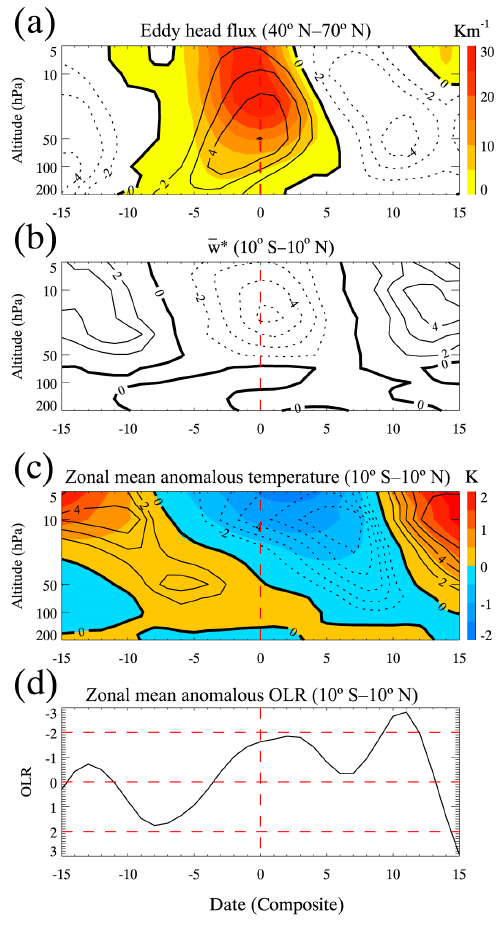
Figure 3. The time–altitude cross section of zonal mean (a) anoma- lous eddy heat flux averaged between 40 and 70 ◦ N shown in phys- ical value (color shades) and t values (contours), (b) the t values of anomalous vertical velocity averaged between 10 ◦ S and 10 ◦ N, and (c) the anomalous temperature averaged between 10 ◦ S and 10 ◦ N shown in physical value (color shades) and t value (contours). (d) The time series of anomalous OLR data averaged between 10 ◦ S and 10 ◦ N shown in t values. The red vertical lines indicate the cen- tral date of the composite SSW event. The dashed horizontal lines in (d) indicate zero and ±